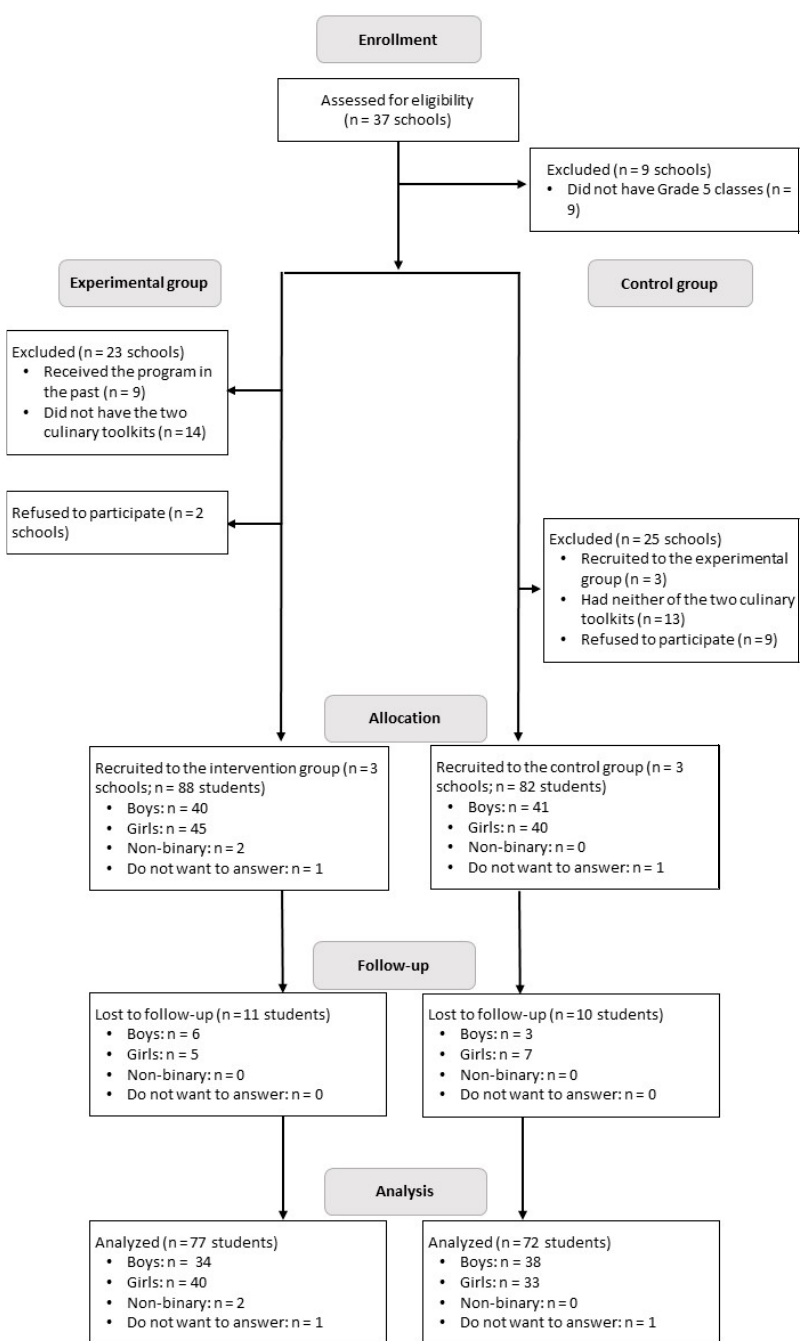
Figure 1. Flow diagram of participants at each stage of the study.